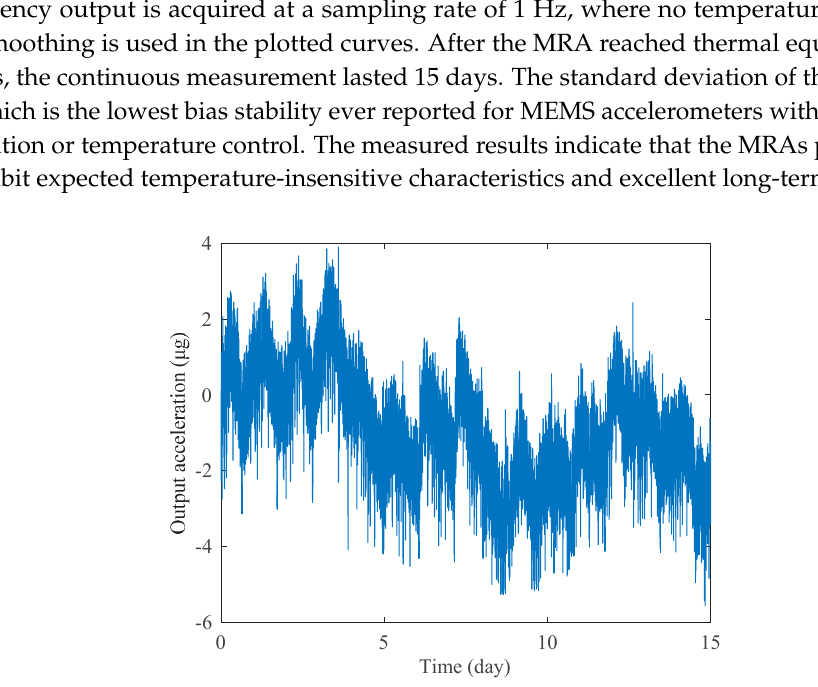
Figure 11. The measured temperature drifts of two MRA prototypes: ( a ) prototype A1 designed by method A, ( b ) prototype B1 designed by method B.